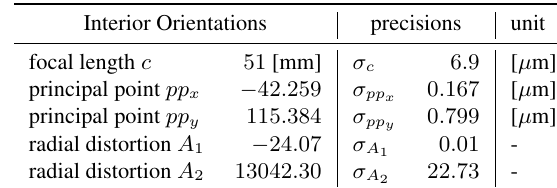
Figure 9. Flight trajectory of DLR helicopter visualized on the Google Earth platform. The green polyline shows the flight trajectory. Source: Google Earth 04/01/2017 tion. 1 This is realized by flying at the right-hand side with respect to flying direction along the motorway, with the left oblique cam- era looking left-down to the motorway, in both forward and back- ward trips. The flight configuration is shown in Figure 9 on the Google Earth platform.